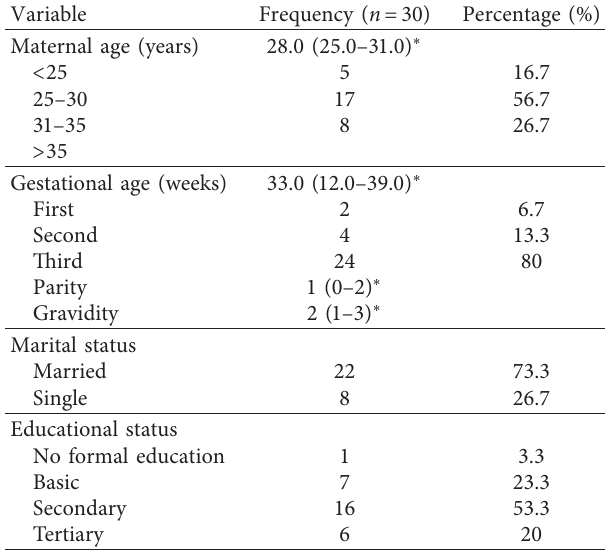
Table 1: Demographic and obstetric characteristics of the study